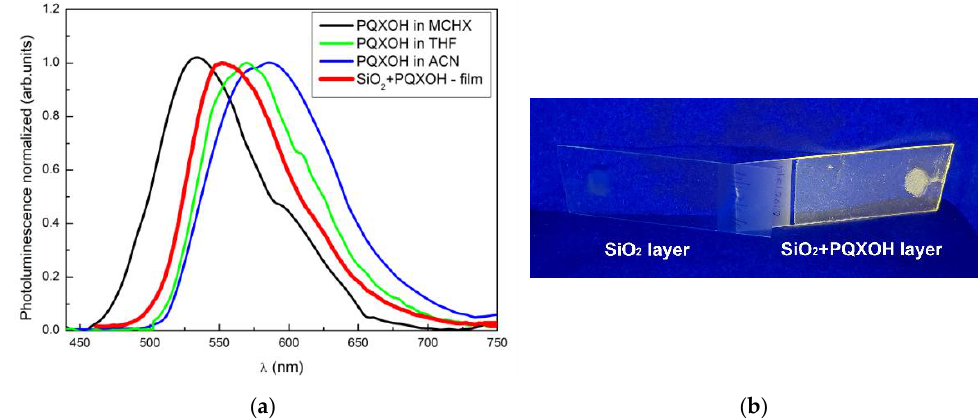
Figure 9. PQXOH photoluminescence in a solution of MCHX (black line), THF (green line), ACN (blue line), and SiO 2 + PQXOH film (red line) ( a ), and the image of substrates with a layer of SiO 2 , respectively, 2d = 2350 nm ( left ) and SiO 2 + PQXOH, 2d = 2780 nm ( right ), illuminated by a lamp λ = 365 nm ( b ).